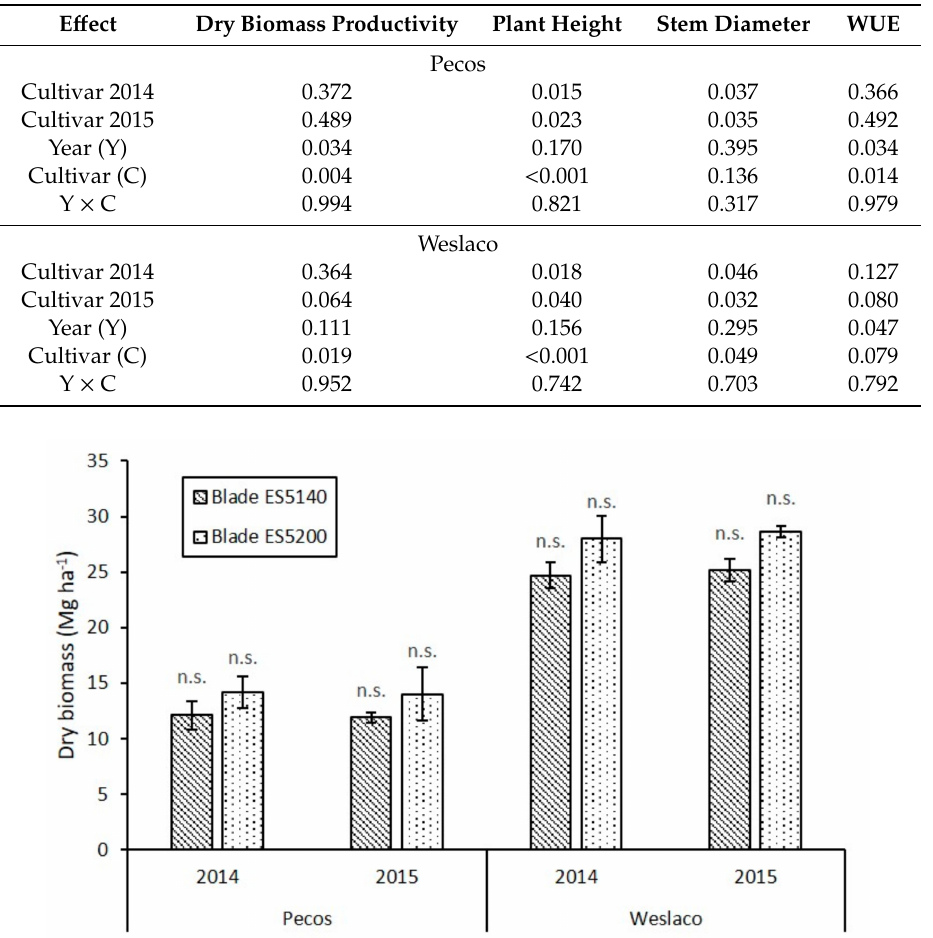
Table 5. Statistical significance values of dry biomass productivity, plant height, stem diameter, and water-use e ffi ciency (WUE).